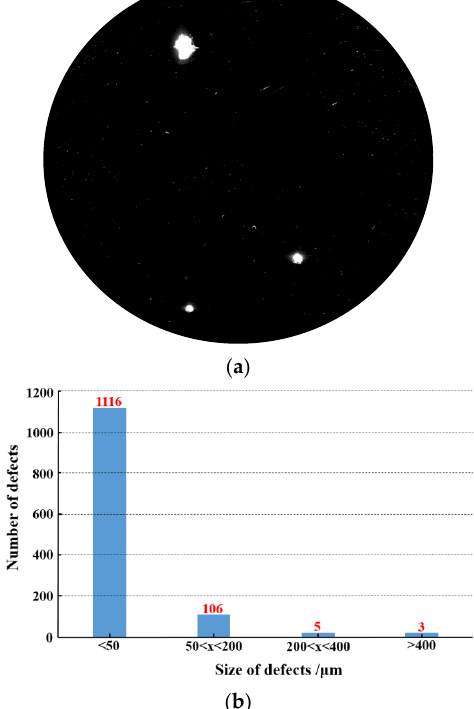
Figure 12. Results of surface defects before MRF polishing: ( a ) Laser scattering detection results; ( b ) The number of defects. As shown in Figure 12, the number of small-scale defects of damaged fused silica optic was 1116. In combination with the results of Figure 11, the material removal depth of the MRF process was set to 6.2 μm, and other process parameters were the same as those in Table 1. The surface detection results after polishing are shown in Figure 13.